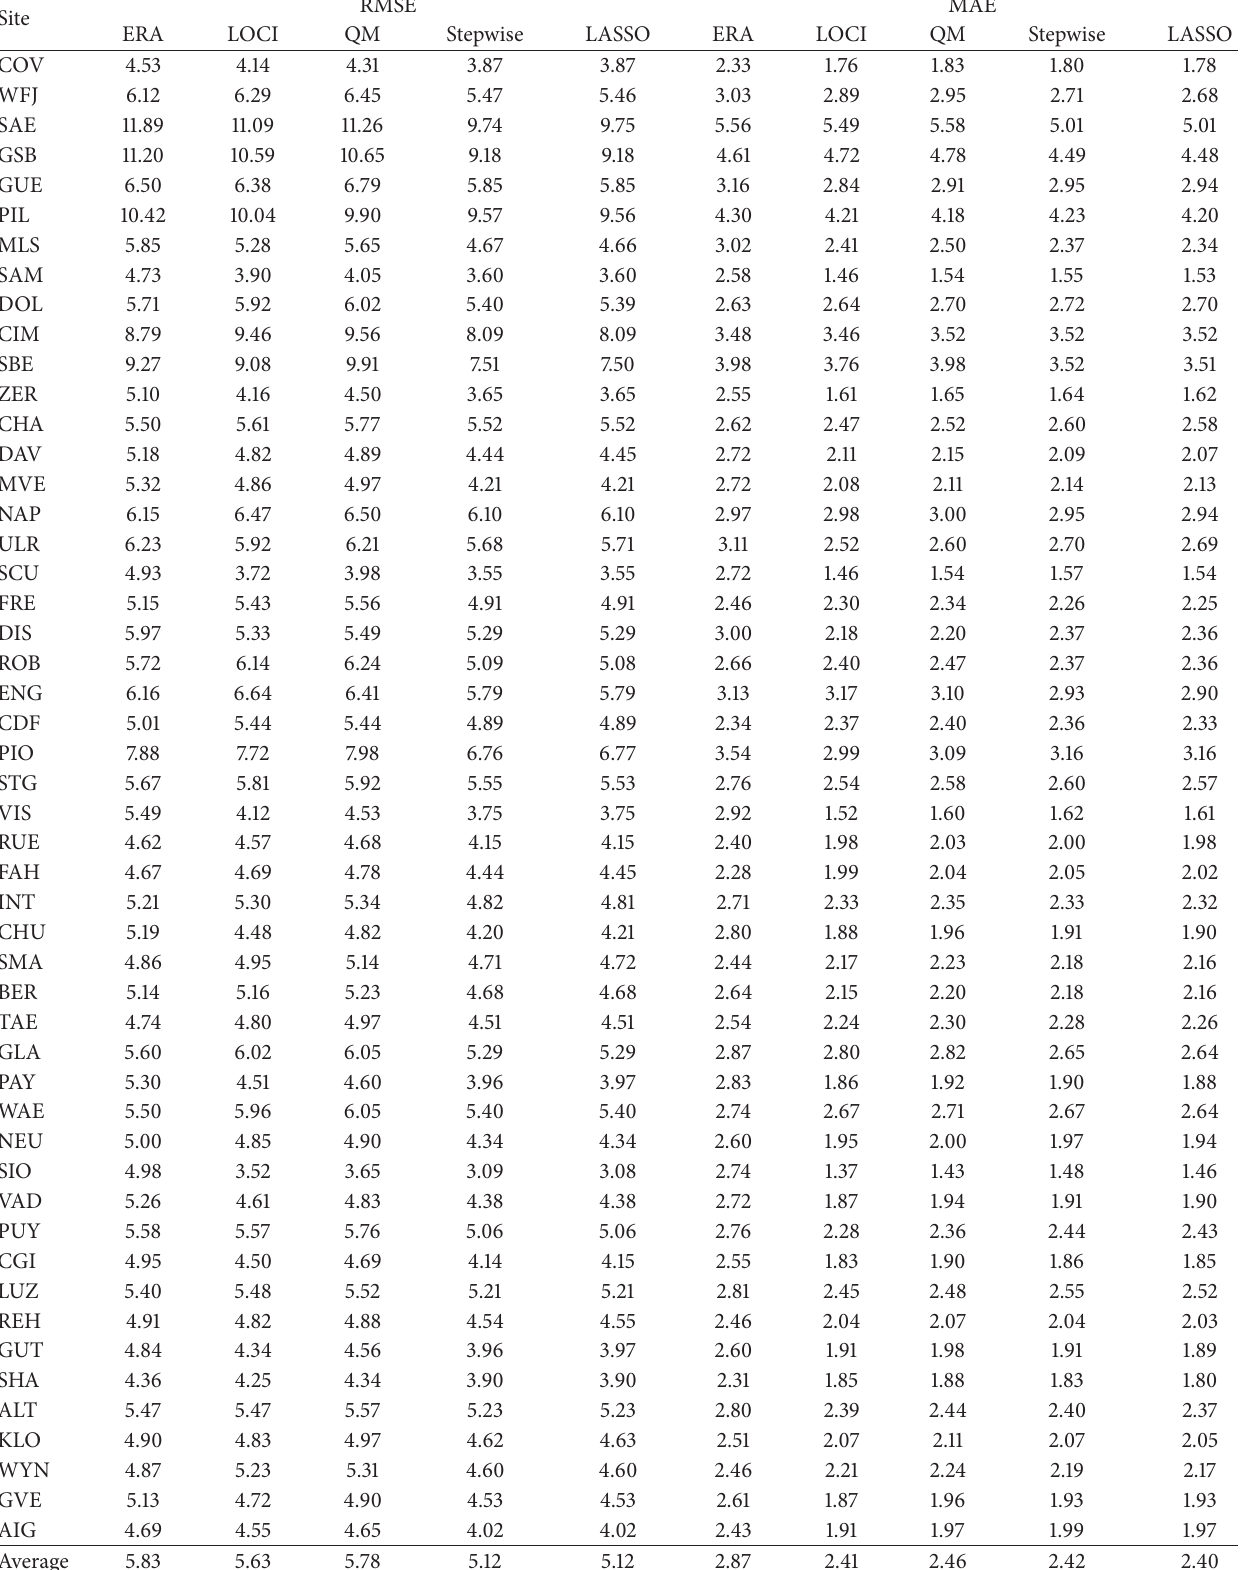
Table 5: Comparison of observations with downscaled daily precipitation for the four downscaling methods, as well as the original ERA- Interim data in precipitation amount (mm) on wet days for the validation period